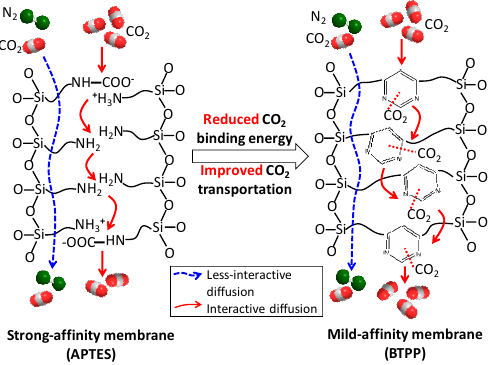
Figure 16. Comparison of CO 2 separation performance for amine-functionalized organosilica membranes at 35 °C. The Robeson upper bound was plotted by assuming a membrane thickness of 500 nm. Results were reorganized from refs. [21–23].